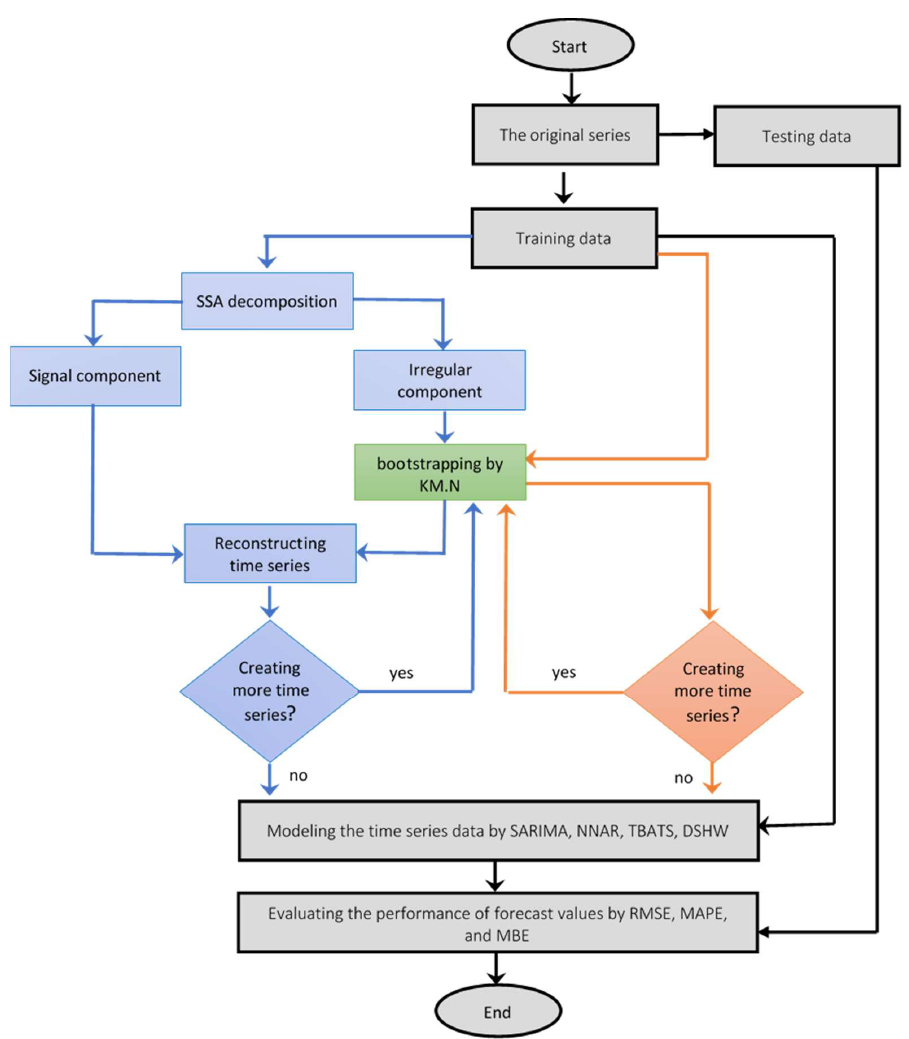
Figure 1. Procedure for generating bootstrapped time series by the SSA-KM.N method. Step 1. Divide the series into the following two parts: training and testing datasets; Step 2. Generate B new series from the original training data by the KM.N method; Step 3. Generate B new series from the original training data by the SSA.KM.N